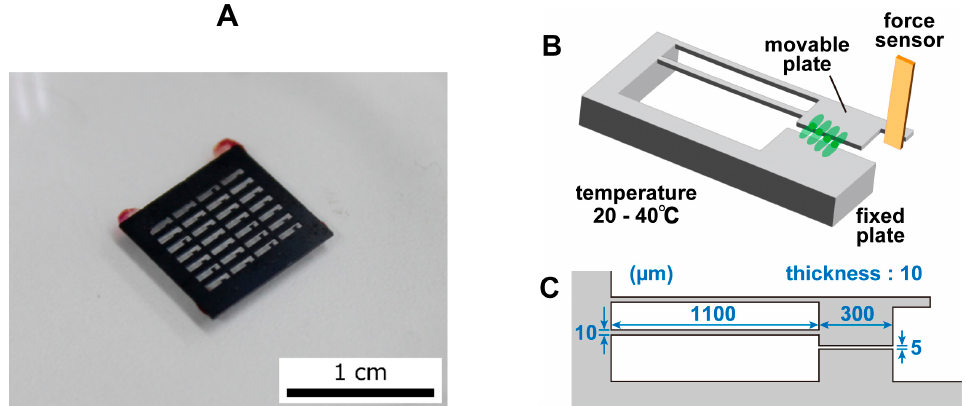
Figure 2. ( A ) The movable plate chip. The 28 movable plates are mounted on one chip. The entire chip is seeded with hiPSC-CMs, and beating cells are selected for measurement. ( B ) Concept of the movable plate. Only the fixed part is attached to the petri dish, and the movable part, which is supported by thin arms, is displaced by the weak force. The force sensor, which is in contact with the protruding part, measures the displacement of the movable part and the force generated by the hiPSC-CMs. In addition, a forced displacement can be applied to the movable plate. ( C ) Dimensions of the movable plate.